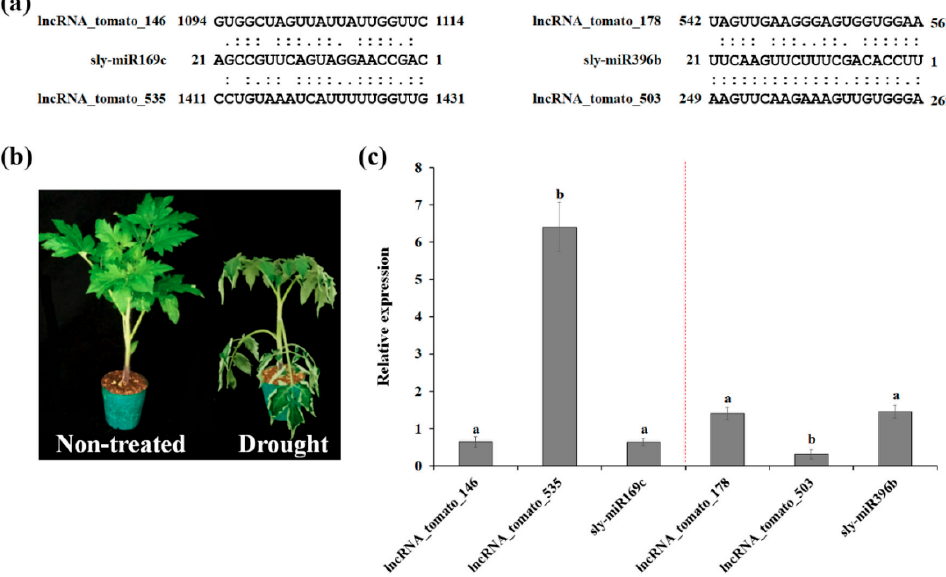
Figure 3. Functional prediction of drought-responsive tomato lncRNAs as potential targets or target mimics of miRNAs. ( a ) The interaction miRNA–lncRNA was identified using psRNATarget webserver (https://plantgrn.noble.org/psRNATarget/analysis). ( b ) Phenotypes of tomato plants after exposure to drought stress for 4 days. ( c ) The relative expression levels of four lncRNA–miRNA pairs were validated by RT-qPCR. The expression levels of selected miRNAs and lncRNAs were calculated relative to their expression in the non-treated sample. Data are means ± standard error (SE). Values in the same column with different superscripted letters are significantly different ( p < 0.05).